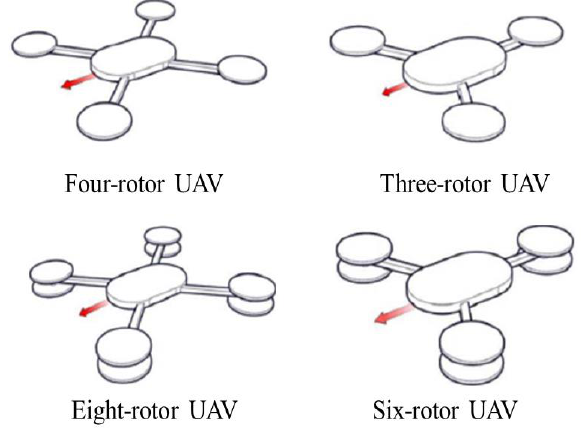
Fig.1. Unmanned Air Vehicle (UAV)